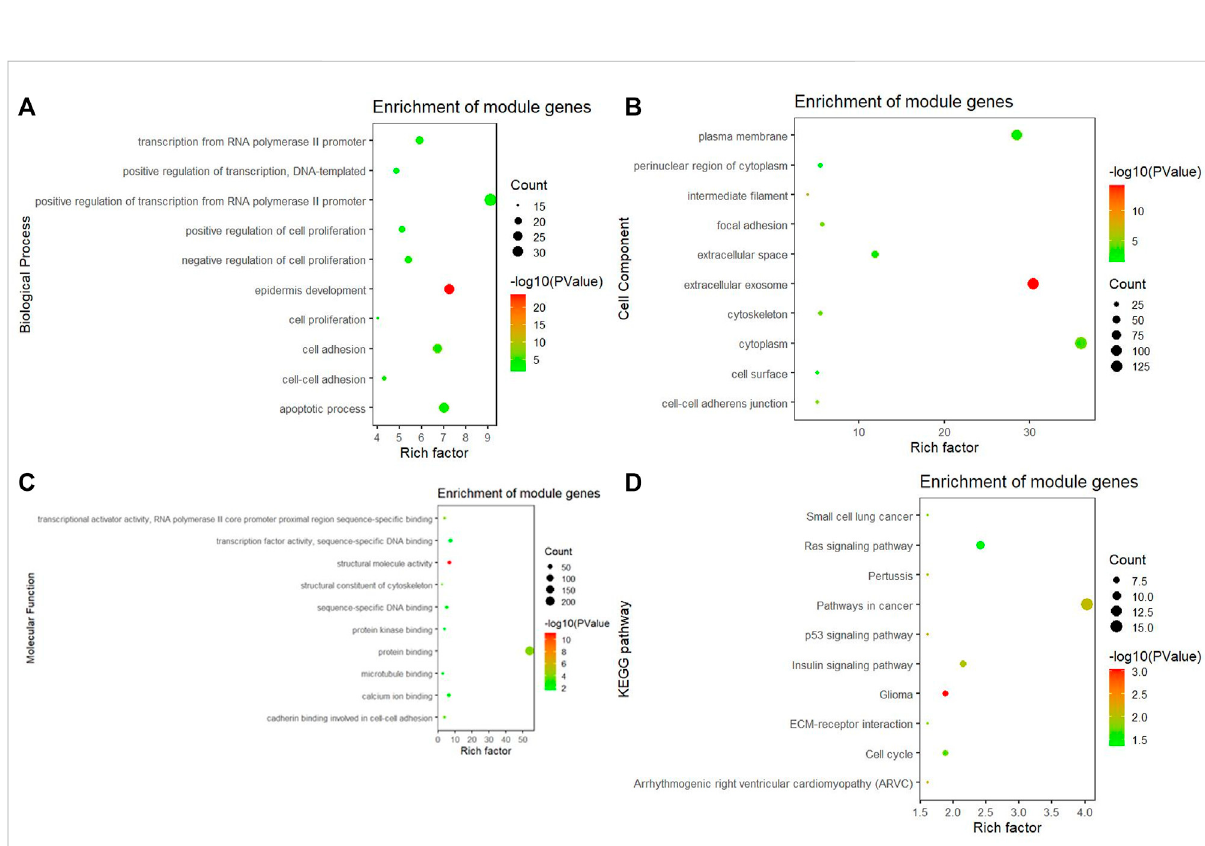
FIGURE 5 GO and KEGG pathway analysis. (A) Biological process of GO, (B) cellular components of GO, (C) molecular function of GO, and (D) KEGG pathway of the turquoise module signi fi cantly enriches pathways related to cancer and cell circle.